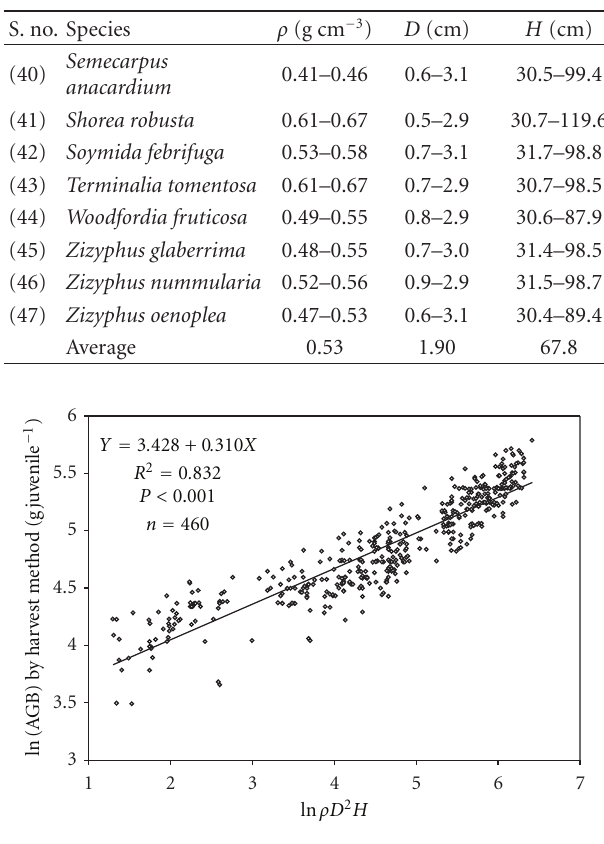
Figure 1: Relationships between the log transformed values of ρD 2 H and the log transformed values of above-ground biomass (AGB, g) estimated by harvest method for 46 juvenile tree species. ρ : wood-specific gravity (g cm − 3 ); D : stem diameter (cm); H : height (cm). Table 2: Regression models for estimating biomass of juvenile trees. SEE: Standard error of estimate. Y : logarithm of above ground biomass (lnAGB); X 1 : ln D 2 ; X 2 : ln ρD 2 ; X 3 : ln D 2 H ; X 4